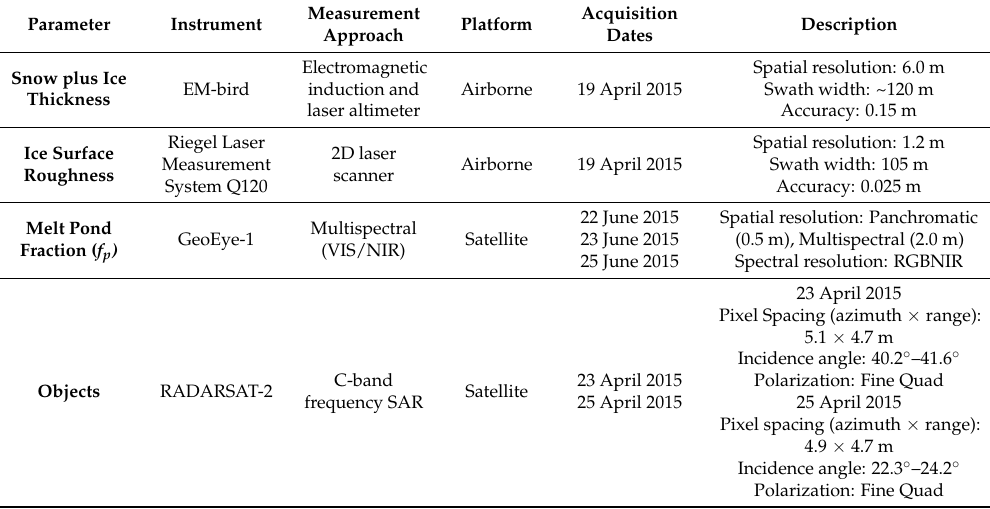
Table 1. Description of the